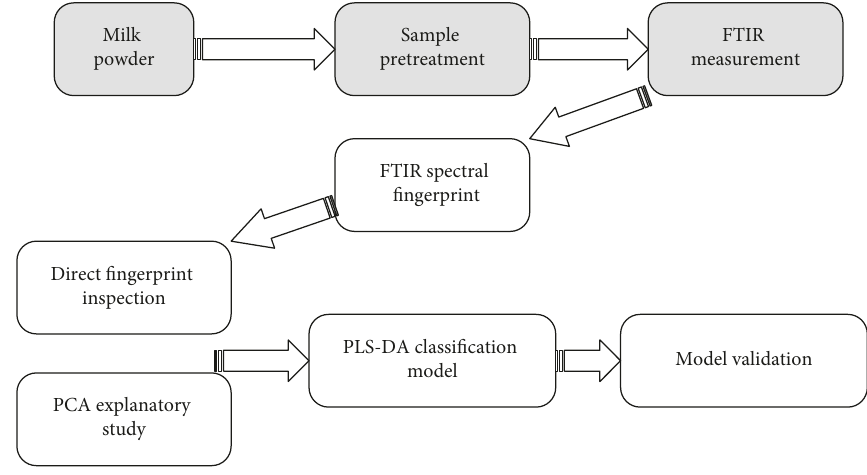
Figure 1: Schematic workflow of this